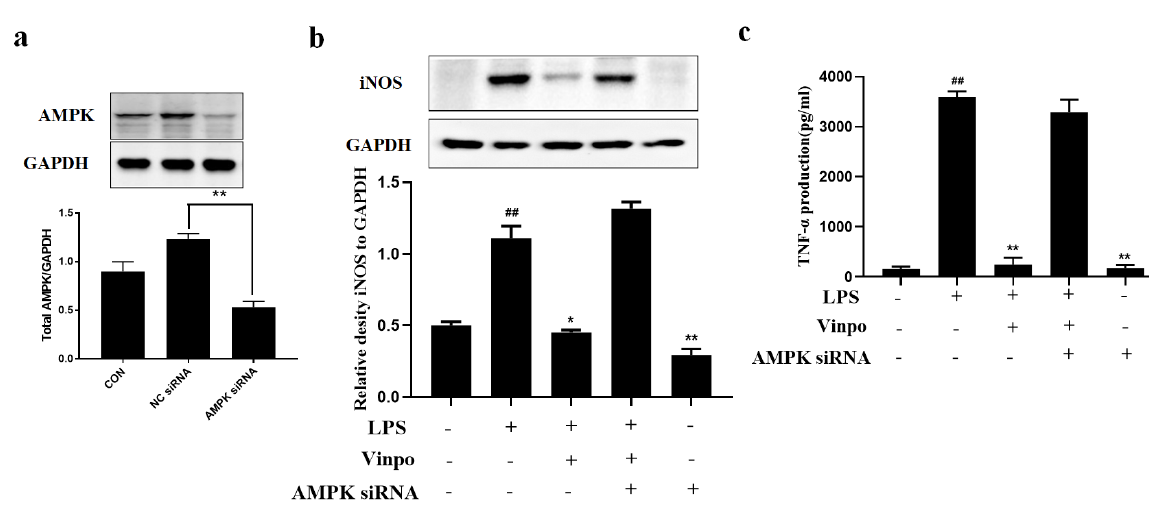
Figure 5. Effect of AMPK activation in the process of anti-inflammatory effects of vinpocetine induced by LPS in BV2 microglia. (a) AMPK siRNA significantly reduced AMPK protein expression in BV2 microglia. Data are representative of three independent experiments. **P < 0.01 compared with indicated groups. (b) Western blot measurement of iNOS protein expression in BV2 microglia. Data are representative of three independent experiments. (c) Supernatants were measured for the release of TNF-α by ELISA assays. Data are representative of three independent experiments. ## P < 0.01, compared with control group, *P < 0.05 and **P < 0.01 compared with LPS